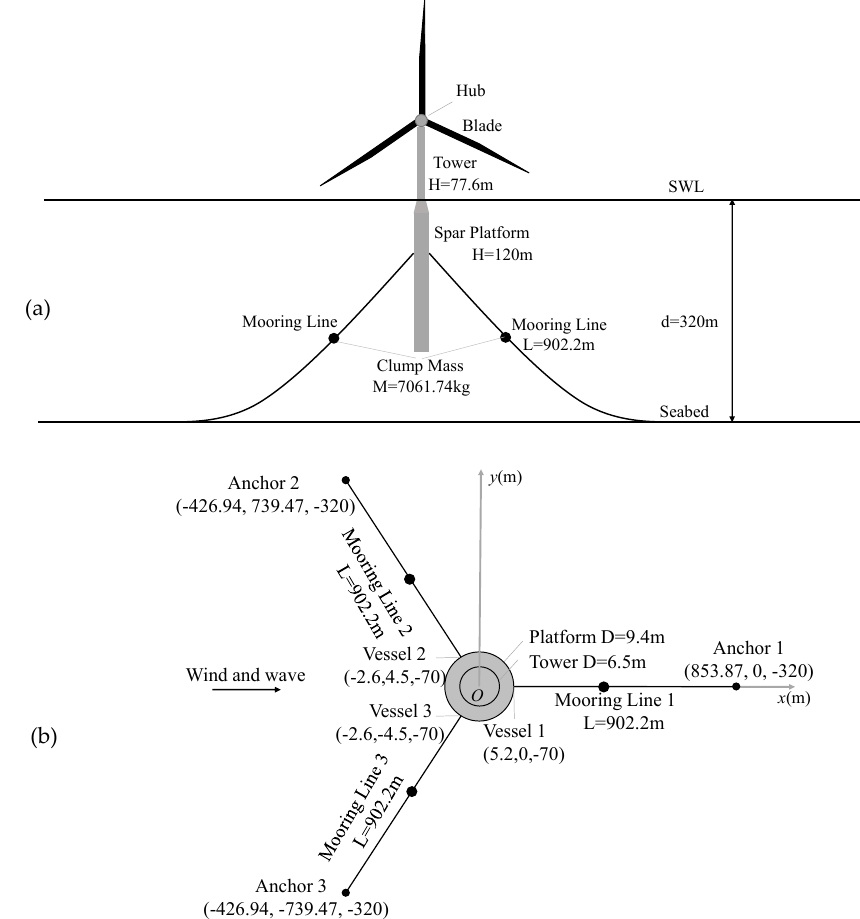
Table 2. Main properties of the OC3-Hywind model.